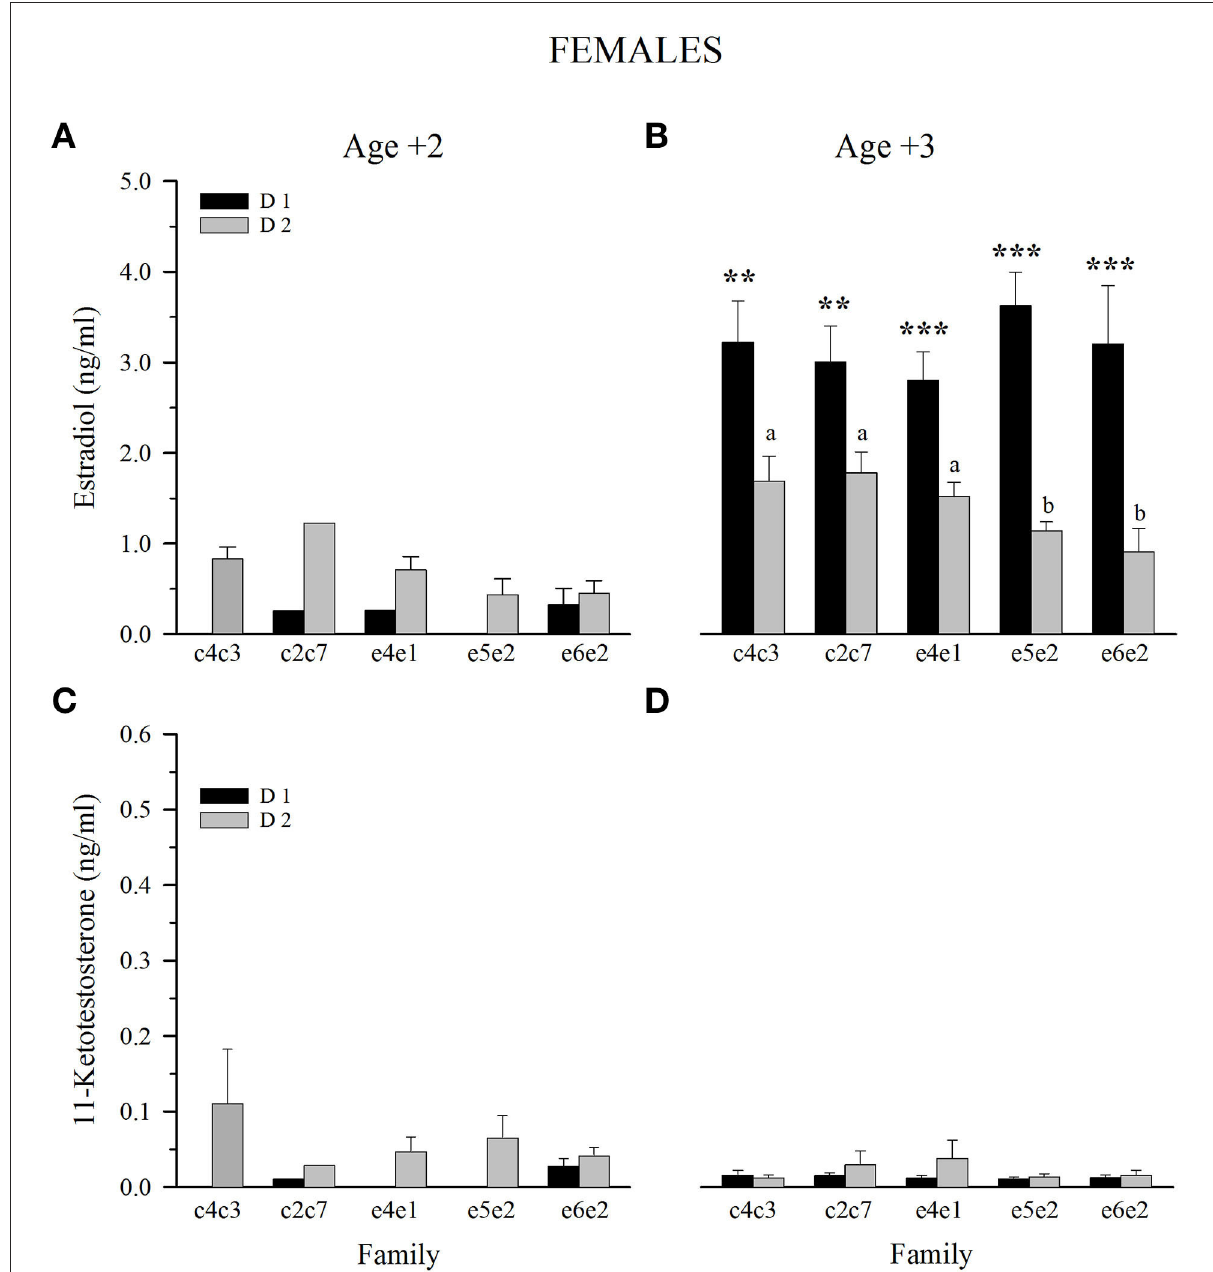
FIGURE5 Plasma levels at spawning season of estradiol (A, C) and 11-ketotestosterone (B, D) in 2 and 3-year-old females fed control (D1) or experimental diet (D2). Values are the mean ± SEM. Different letters indicate significant differences between families fed D2. Asterisks indicate significant differences between dietary groups within each family (Student’s t -test, ** P < 0.01, *** P <